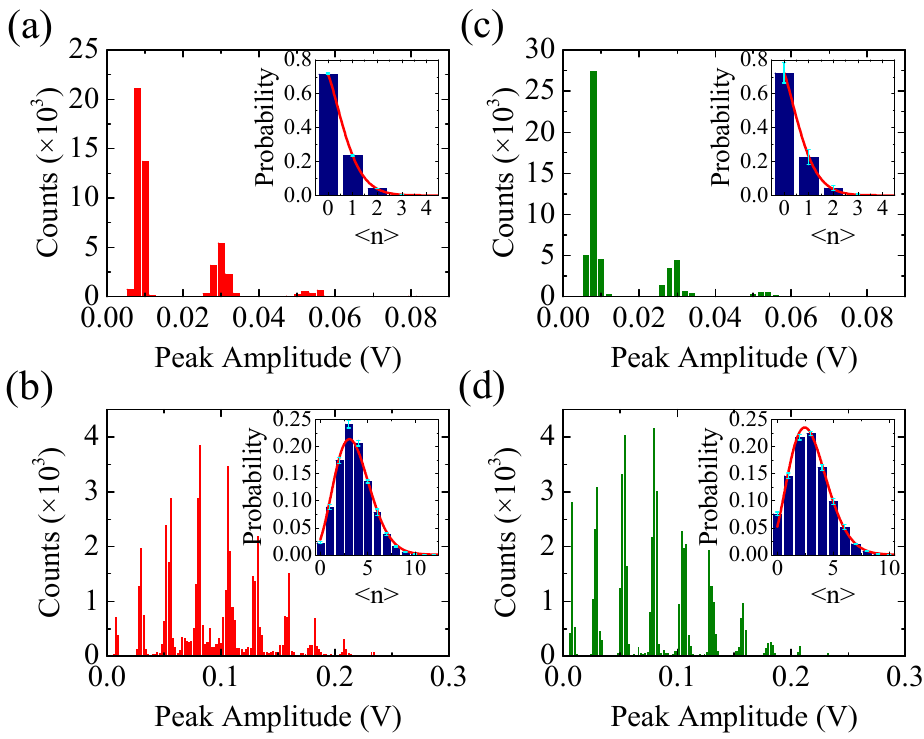
Figure 3. Detector voltage amplitude histogram at 791 nm ( a , b ) and 523 nm ( c , d ). The inset shows the corresponding photon number distribution histogram. Error bars in the insets were obtained by the standard divisions on five independent measurements.